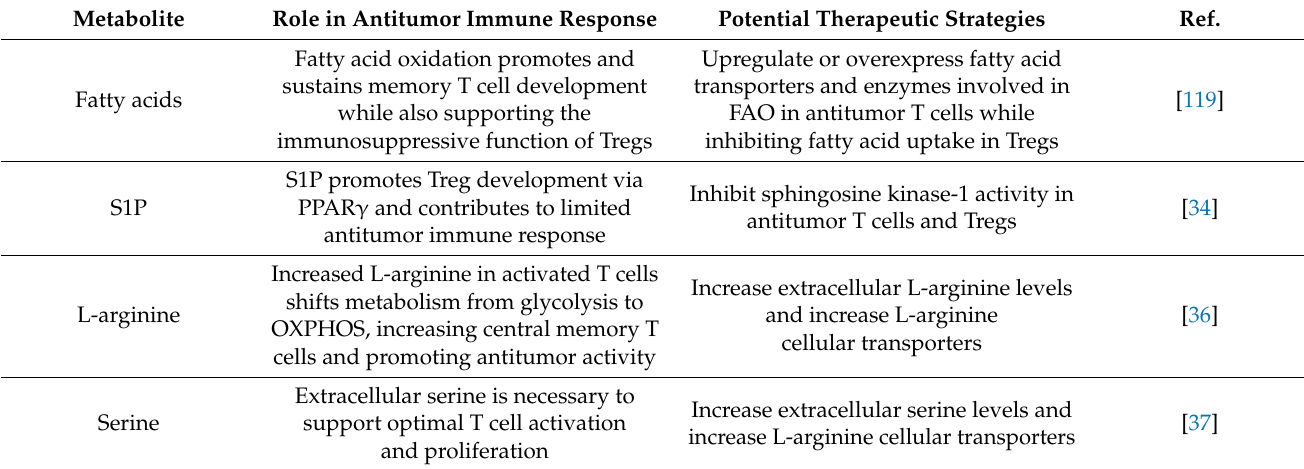
Table 1. Novel metabolite targets in antitumor immunometabolism.